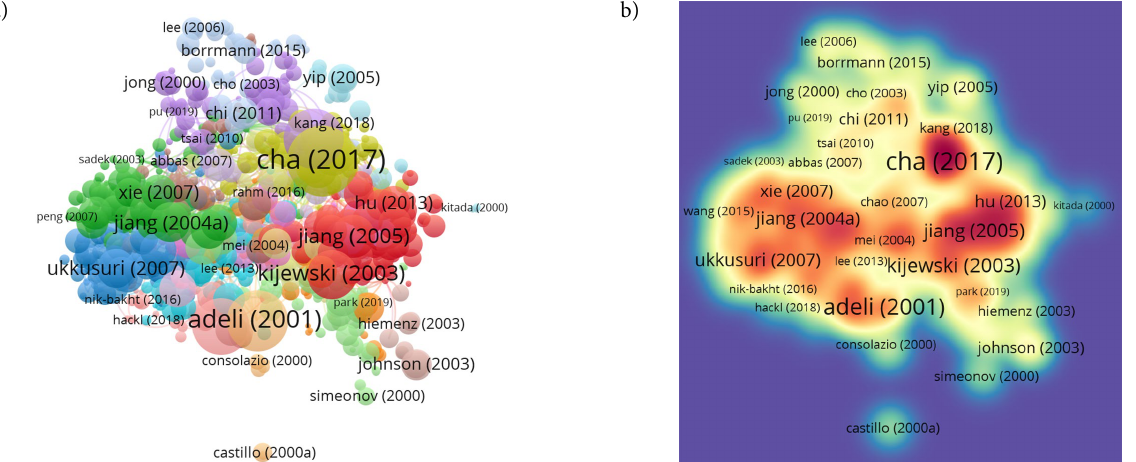
Figure 7. The citation analysis of publications in the CACAIE: a – the citation network of publications; b – the density visualization